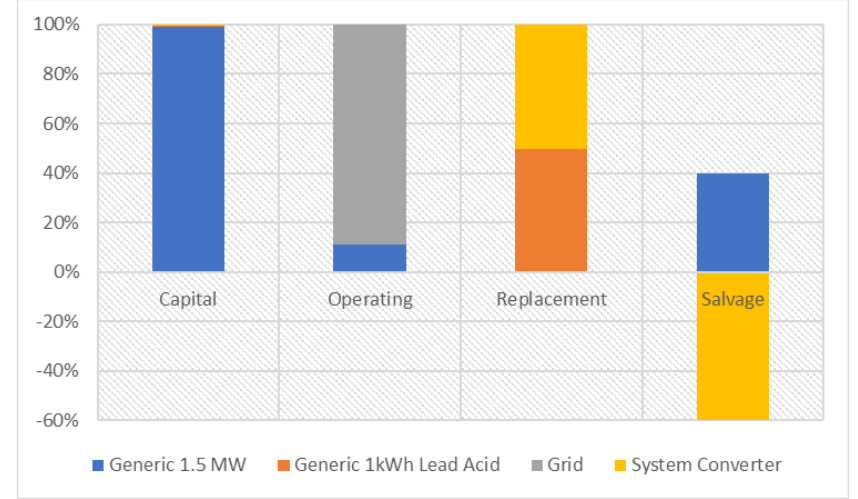
Figure 14. NPC and COE for multi-year and single-year modules .